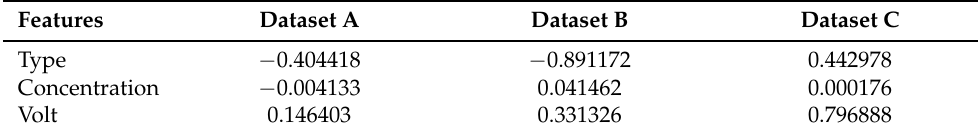
Table 4. Sorted correlation values of dataset features to the current response.